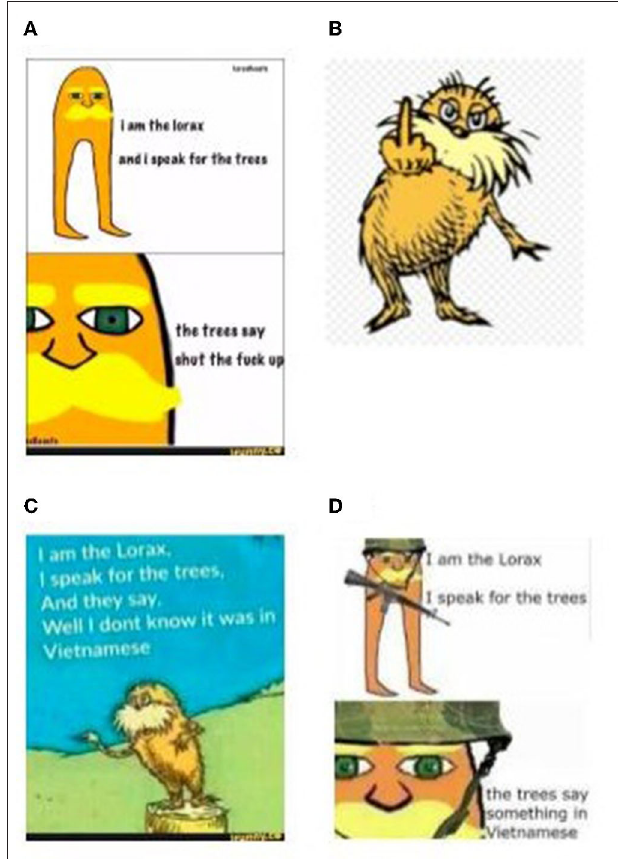
FIGURE 5 | Other memes. (A) Simplified Meme (https://knowyourmeme.com/ photos/1038793-i-am-the-lorax-i-speak-for-the-trees) 7 . (B) Middle Finger Meme (https://www.pngkin.com/pen/hbmbow/) 8 . (C) Vietnam book meme (https://www.pinterest.com/pin/640074165772706245/) 9 . (D) Vietnamese military meme (https://www.pinterest.com/pin/819936675887264406/) 10 .